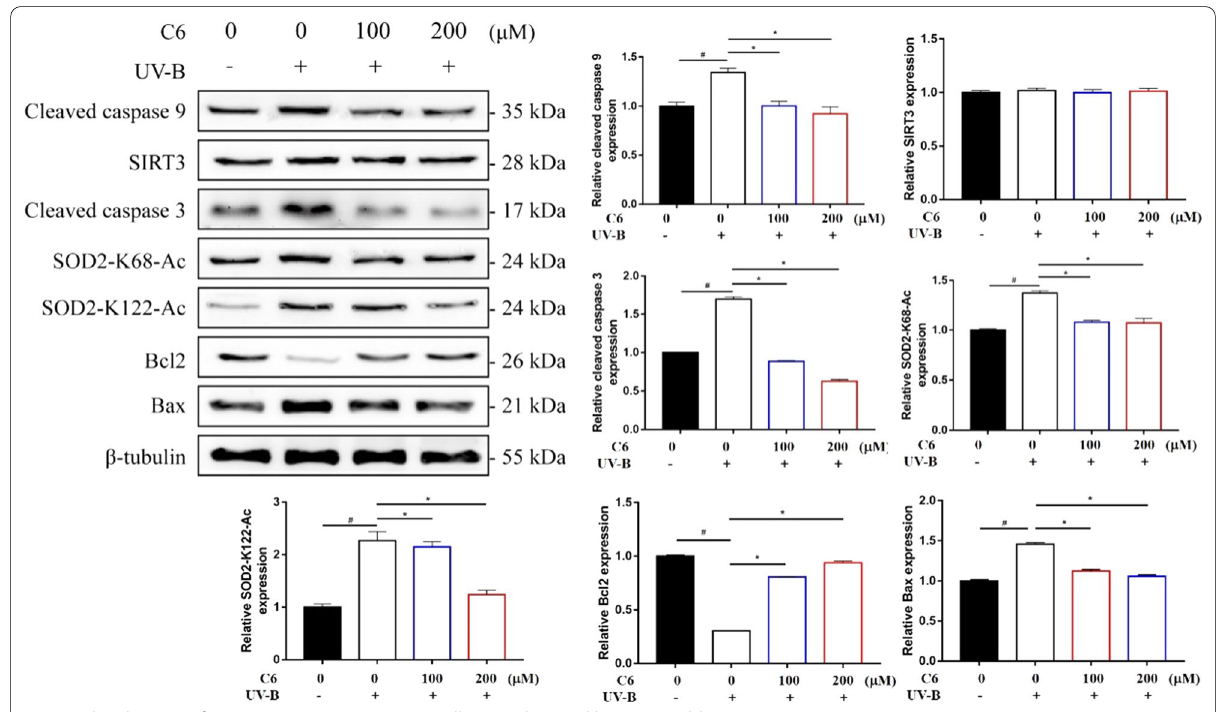
Fig. 5 The changes of protein expression in HaCaT cells were detected by Western blot